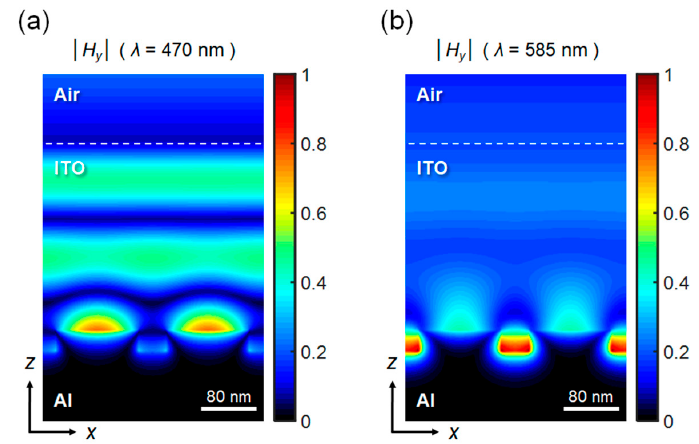
Figure 5. Distributions of the magnetic field within the structure when ( a ) 470 and ( b ) 585 nm transverse magnetic (TM) polarized plane waves illuminate the structure at normal incidence. The structural parameters are p = 160 nm, w = 40 nm, t g = 30 nm, and t d = 270 nm. The calculation domain includes two unit cell elements, and the color scale is properly normalized to compare the field